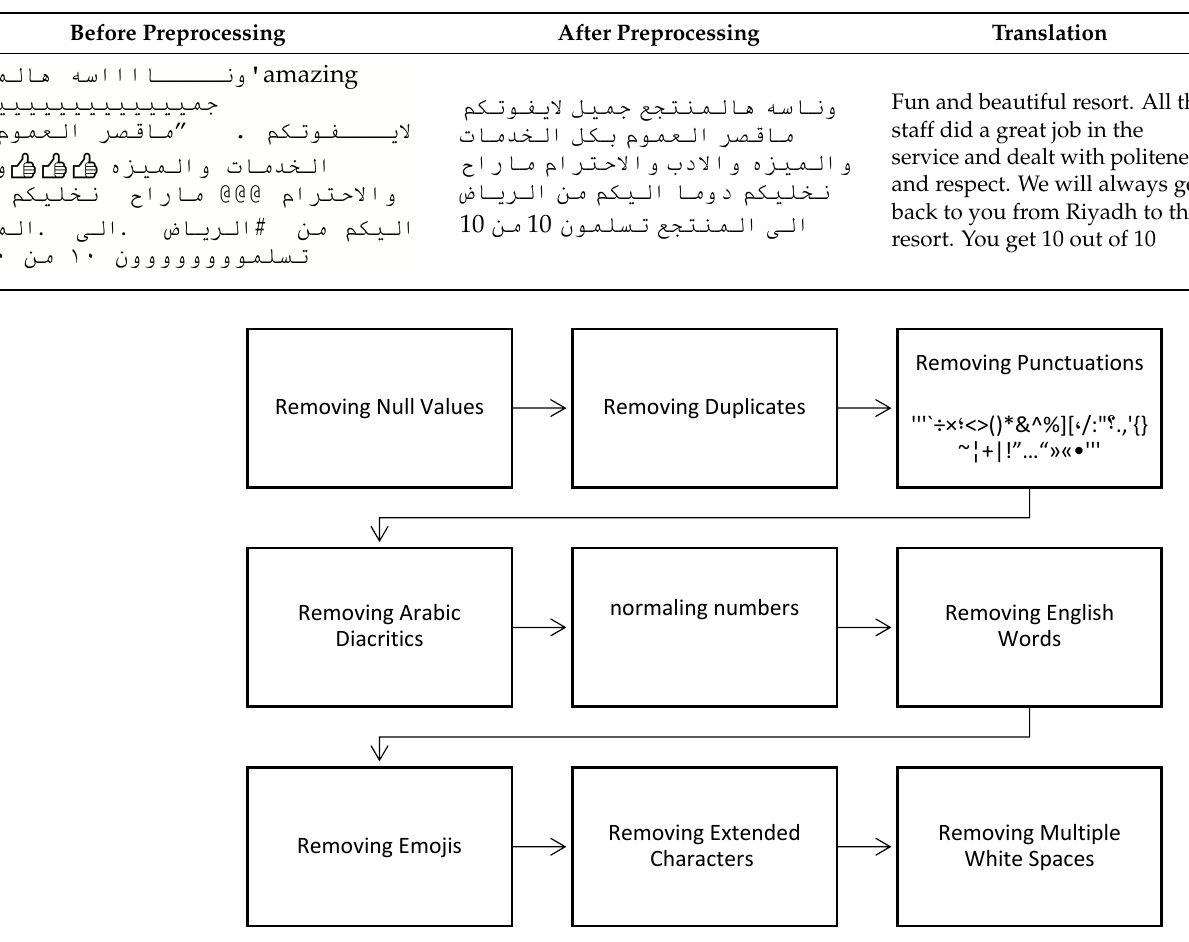
Figure 4. Text preprocessing steps applied in this work.